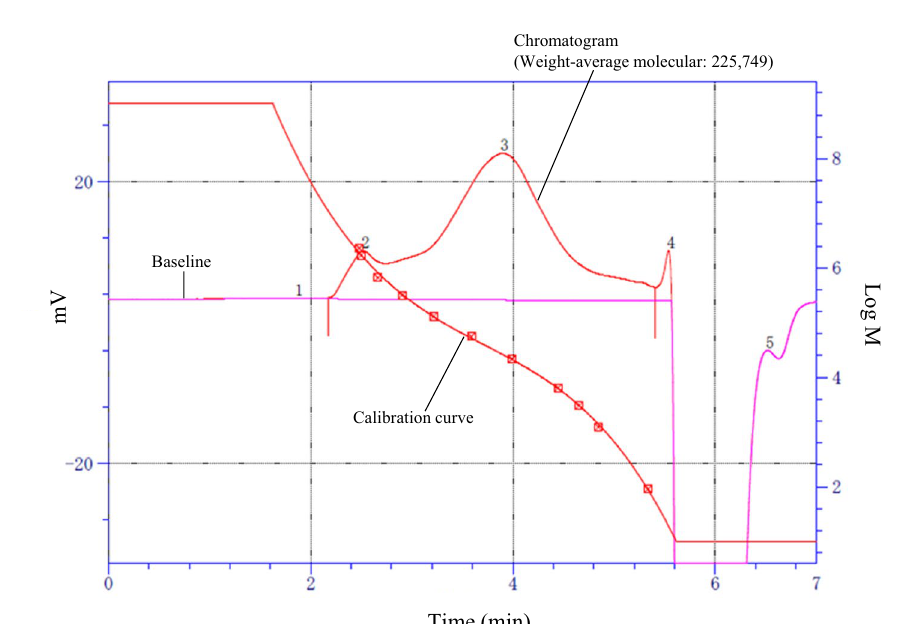
Figure 3. GPC Chromatograms of > 3 k Da fraction of corn silk water